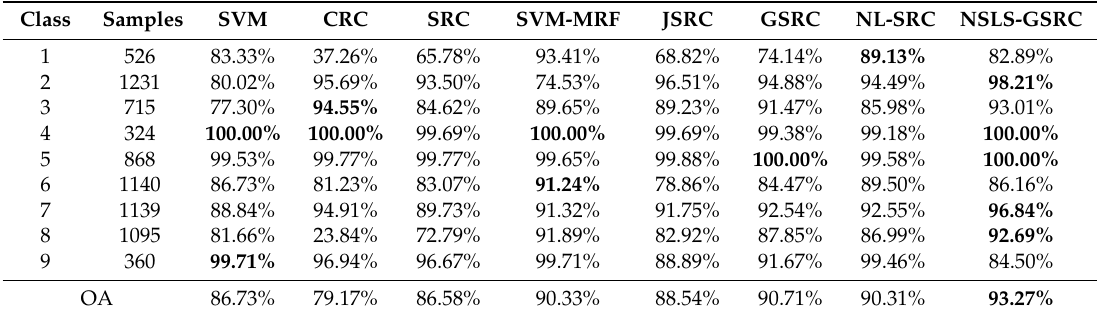
Table 5. Classification accuracies (in percent) obtained by the different tested methods for the ROSIS University of Pavia scene. In all cases, 270 labeled samples in total (30 samples per class) were used for training. The best results are in